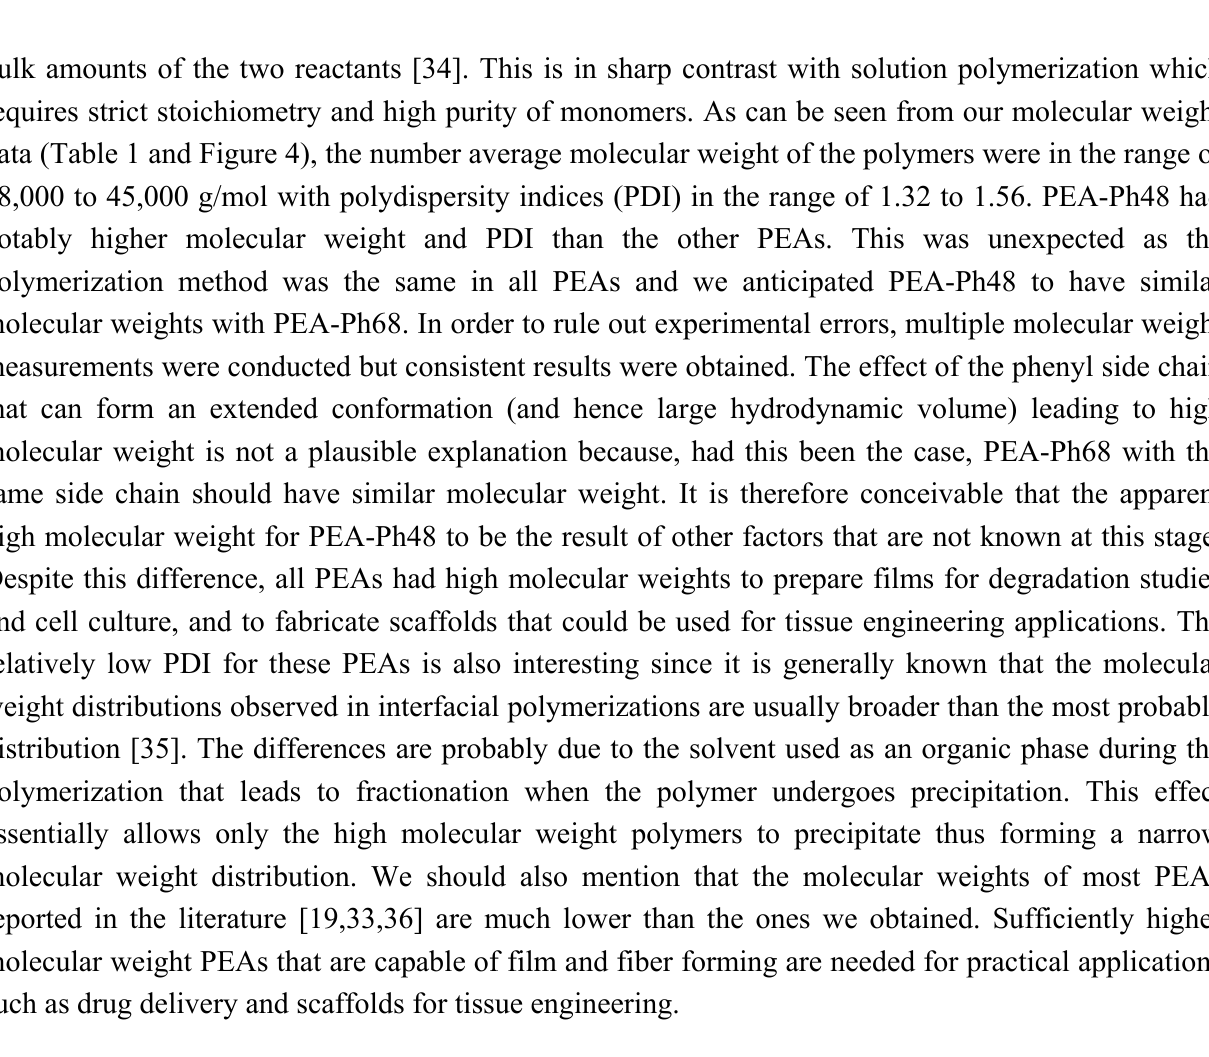
Table1. Yields, molecular weights, and glass transition temperatures of PEAs synthesized from L -phenylalanine and L